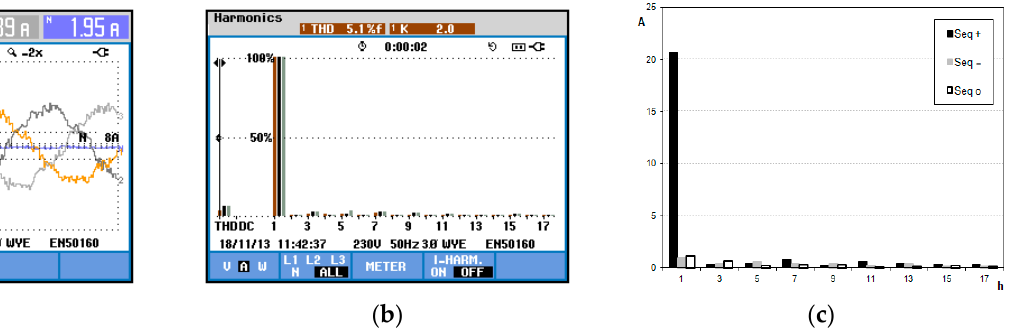
Figure 45. Case 6 - four-wire ShAPF operating with unbalanced loads: ( a ) three-phase currents; ( b ) harmonic spectrum of the currents; ( c ) harmonic spectrum of the current sequence components (maximum values).